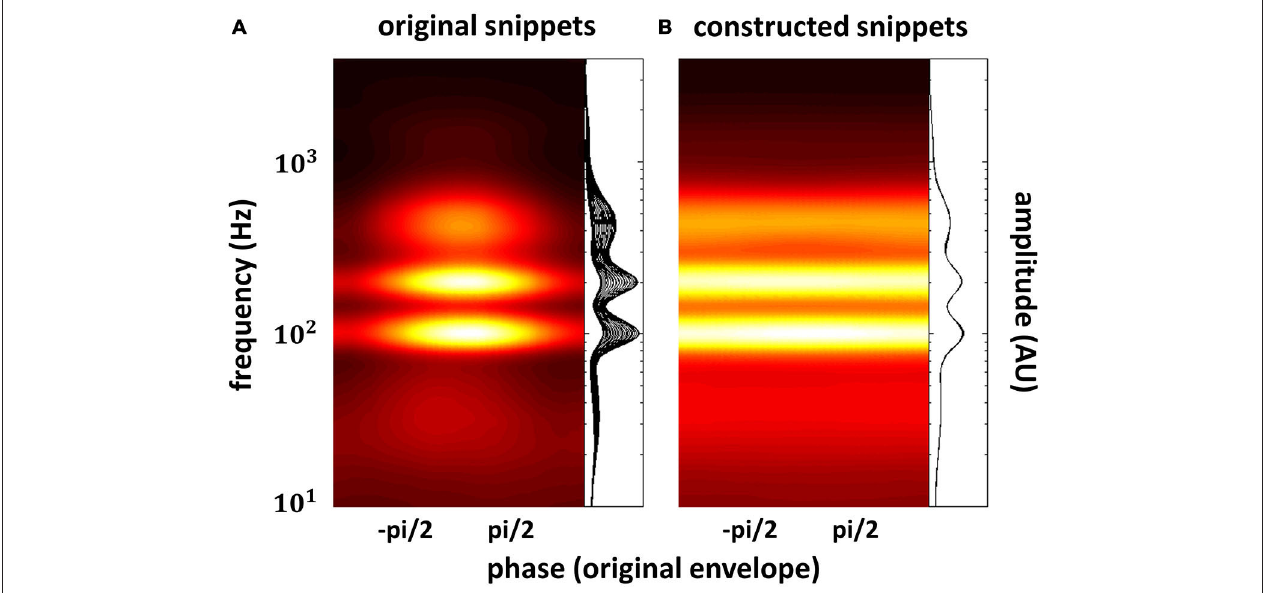
FIGURE 3 | Everyday speech sound (A) contains pronounced fluctuations in spectral energy (color-coded or shown as a family of curves; one curve for each phase bin of the speech envelope) that depend on the phase of the speech envelope. These (low-level) rhythmic fluctuations in energy per se might result in an apparent alignment between neural activity and speech envelope, as strong neural excitation (here at phase 0, due to high spectral energy) periodically alternates with weak neural excitation (here at phase ± pi, due to low spectral energy). Genuine high-level phase entrainment requires stimuli without those systematic fluctuations in spectral energy, as shown in (B) . The construction of those stimuli has recently been reported (Zoefel and VanRullen, 2015b), and results obtained there are described in this review. Reproduced with permission from Zoefel and VanRullen